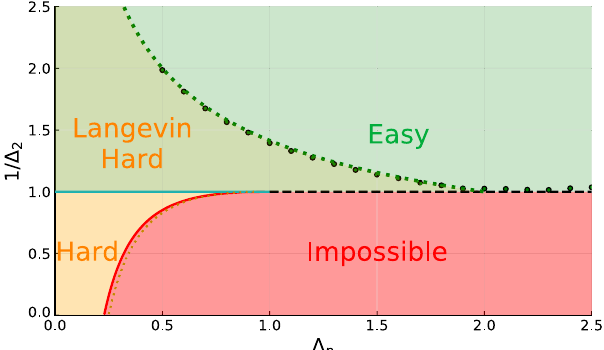
FIG. 1. Phase diagram of the spiked 2 þ 3 -spin model (the matrix and order-3 tensor are observed). In the easy (green) region, the AMP achieves an optimal error smaller than the random pick from the prior. In the impossible region (red), the optimal error is as bad as the random pick from the prior, and the AMP achieves it as well. In the hard region (orange), the optimal error is low, but the AMP does not find an estimator better than the random pick from the prior. In the case of the Langevin algorithm, the performance is strictly worse than that for the AMP in the sense that the hard region increases up to the ffiffiffiffiffiffiffiffiffiffiffi p Δ 2 line 1 = Δ (cid:1) 2 ¼ max ð 1 ; Þ , depicted by green dots. The green 3 = circles are obtained by numerical extrapolation of the Langevin state evolution